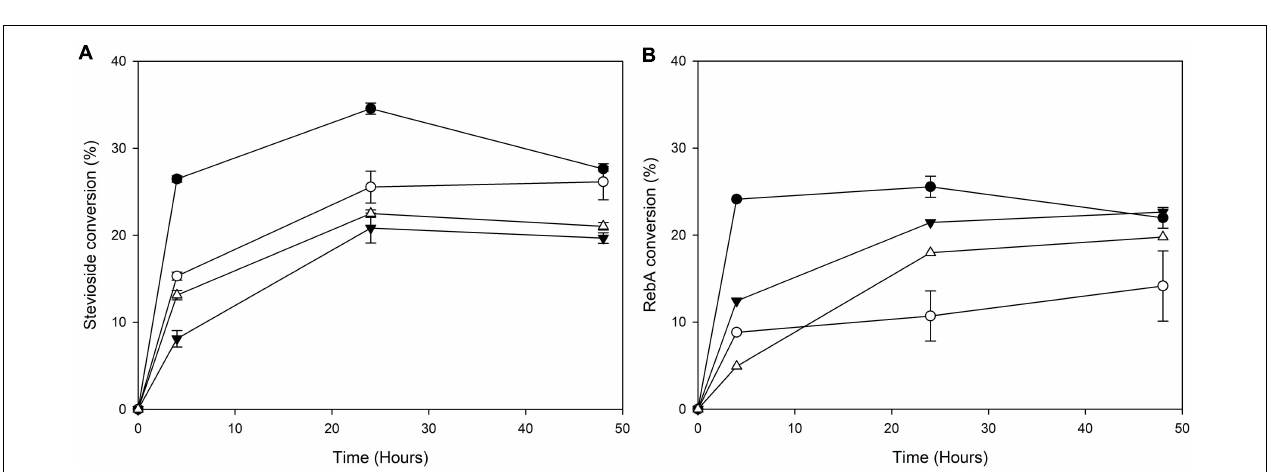
FIGURE 6 | Conversion of different concentrations of (A) stevioside and (B) RebA by Mt Bgl3a. Black circles : 2.5 g L − 1 glycoside, white circles : 5 g L − 1 glycoside, black inverted triangles : 7.5 g L − 1 glycoside, white triangles : 10 g L − 1